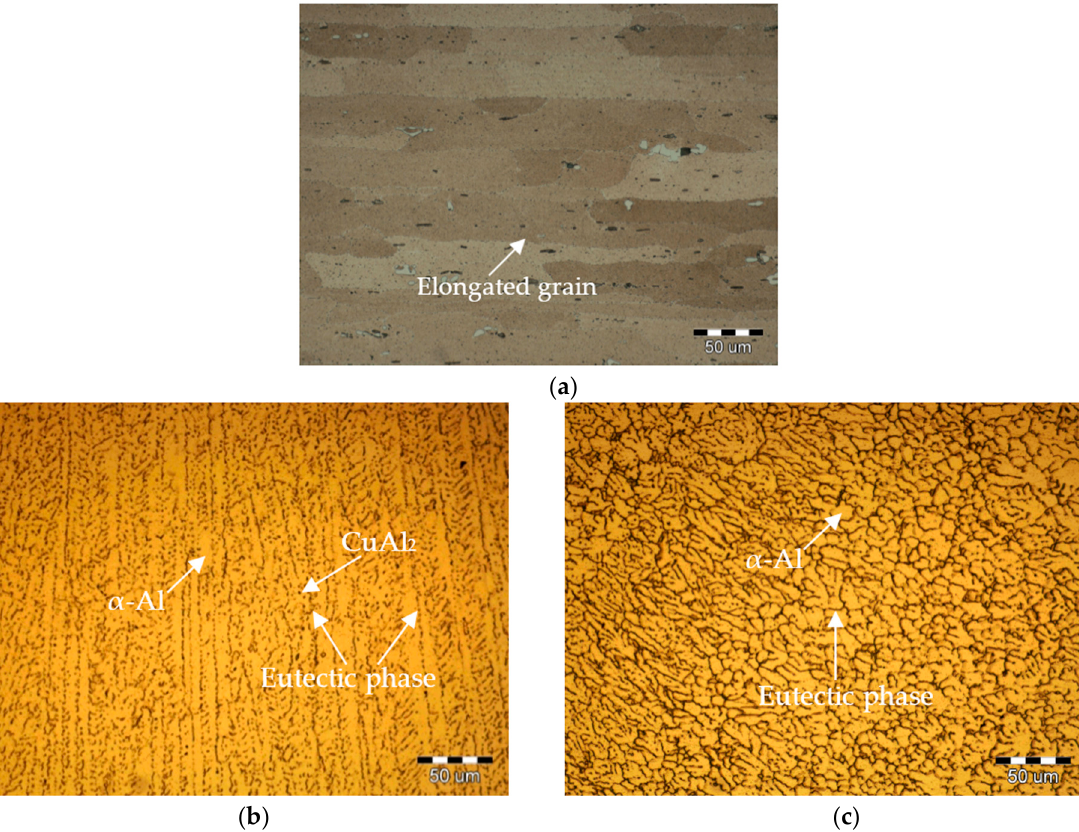
Figure 6. Microstructure of ( a ) base metal; ( b ) weld of laser welding; and ( c ) weld of PCALW.